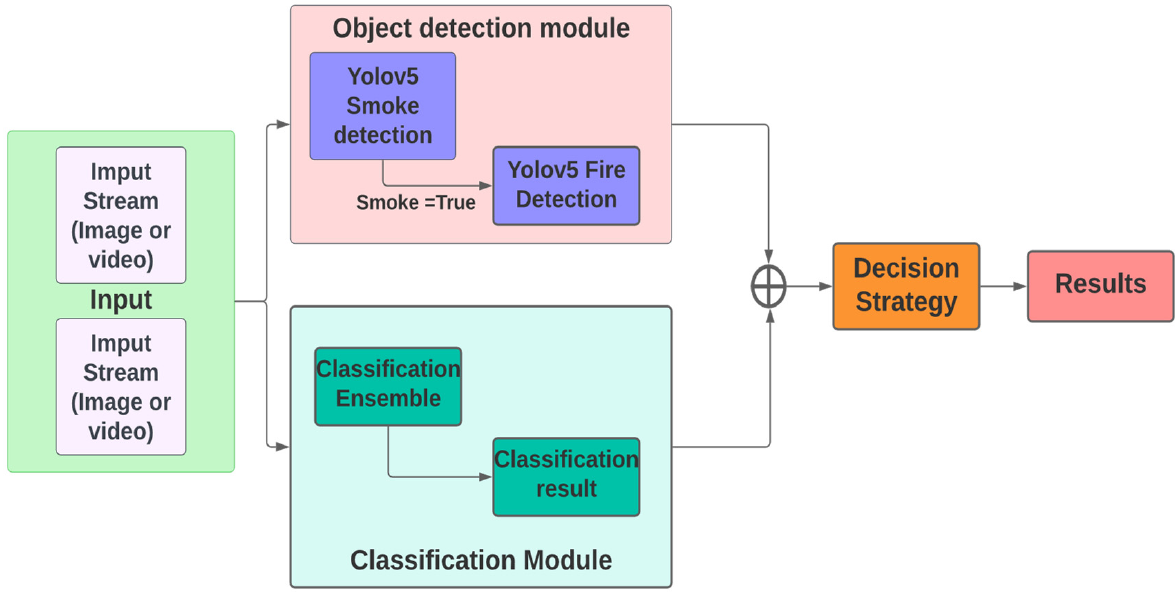
Figure 3. Our proposed method architecture: the method is divided into 4 blocks: input block, classification block, detection block, and lastly, the result block.